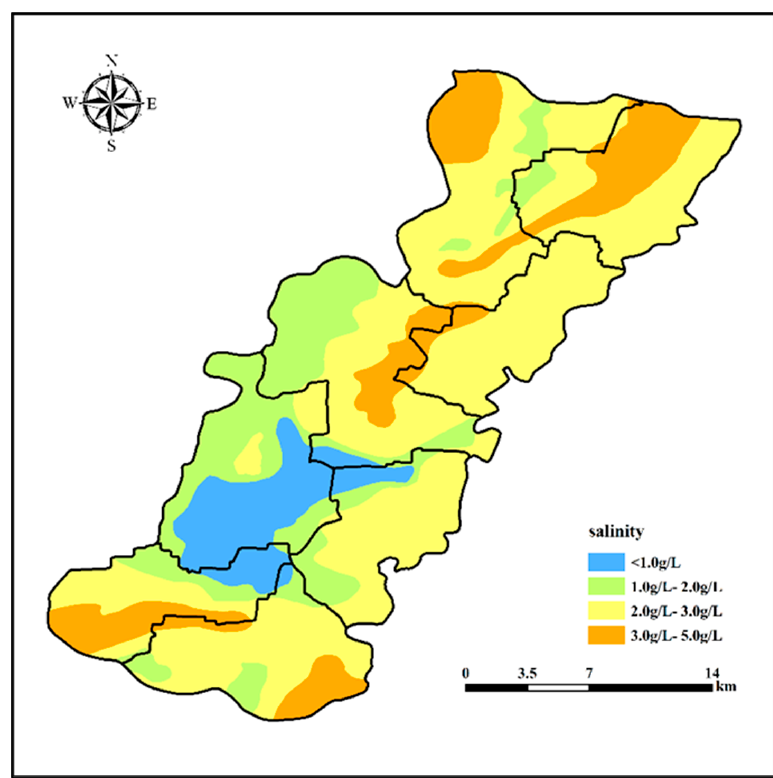
Figure 2. Distribution of brackish water in Guantao County.